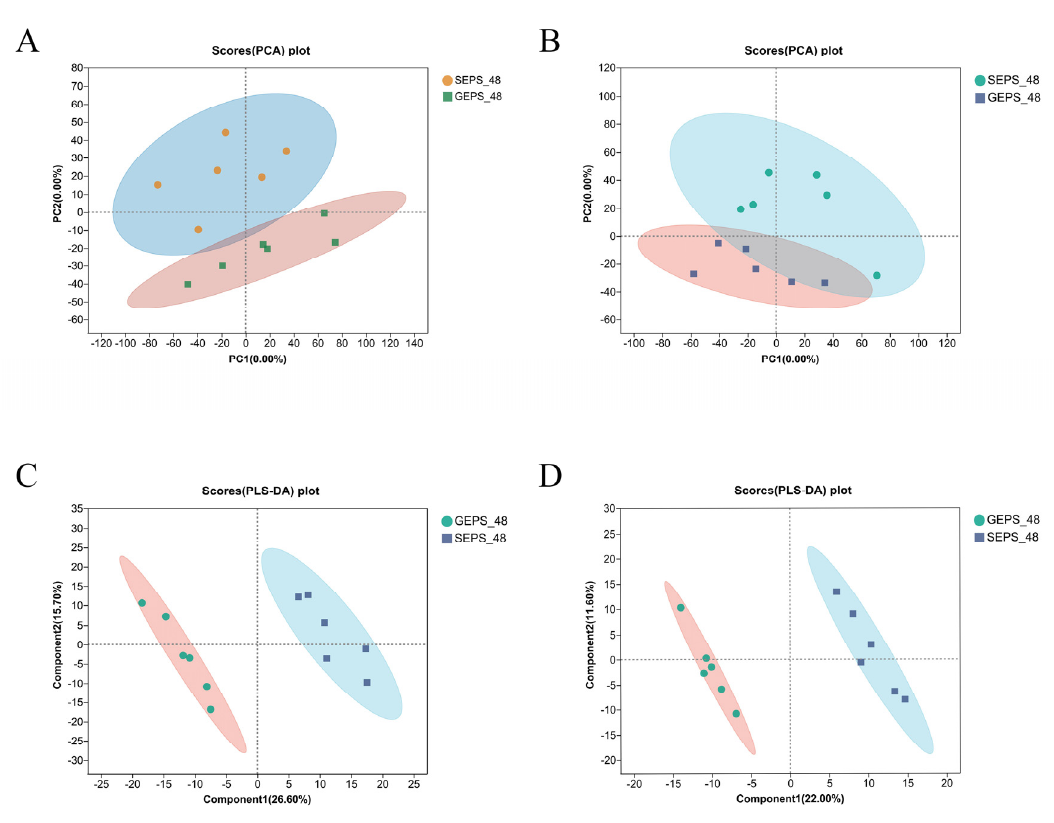
Figure 3. ( A , B ) PCA score chart of SEPS_48 and GEPS_48 comparison groups’ metabolite profile in positive and negative ion modes. ( C , D ) PLS − DA score chart of SEPS_48 and GEPS_48 comparison groups’ metabolite profile in positive and negative ion modes.